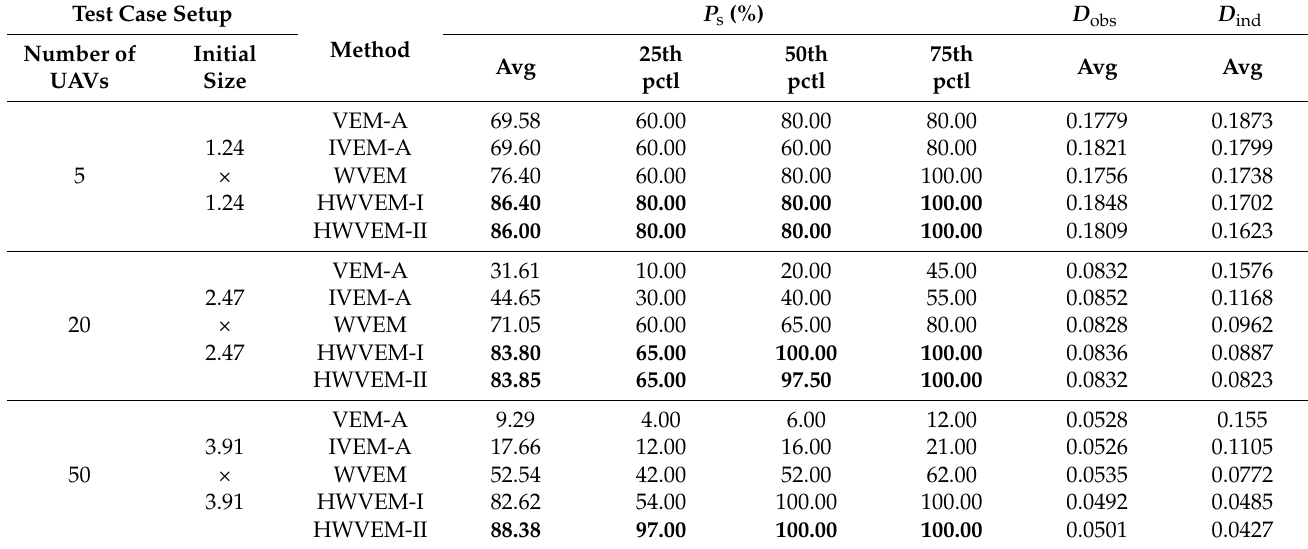
Table 2. The task performance of VEM-A, IVEM-A, WVEM, HWVEM-I and HWVEM-II Test Case